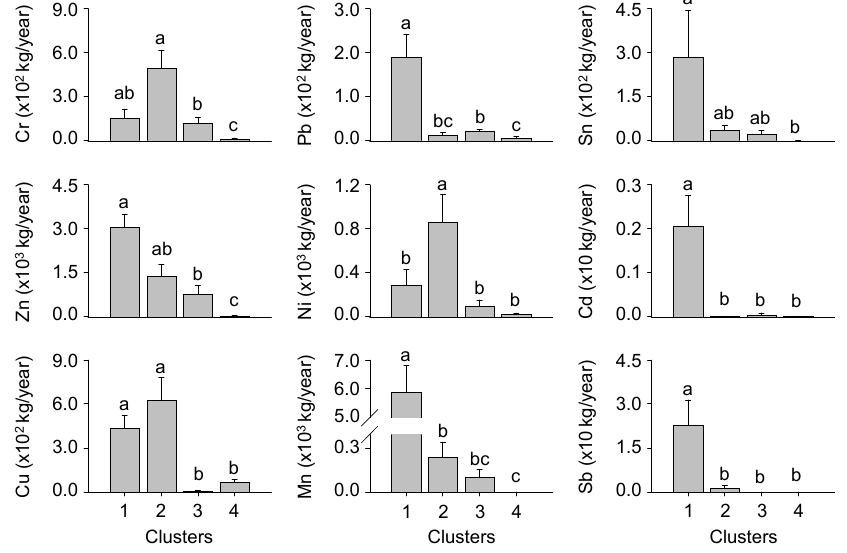
Figure 6. Differences in nine heavy metals among the four clusters defined in the SOM. Different letters indicate significant differences between the clusters based on Dunn’s test after a Kruskal–Wallis test ( p < 0.05). Error bars indicate standard error.